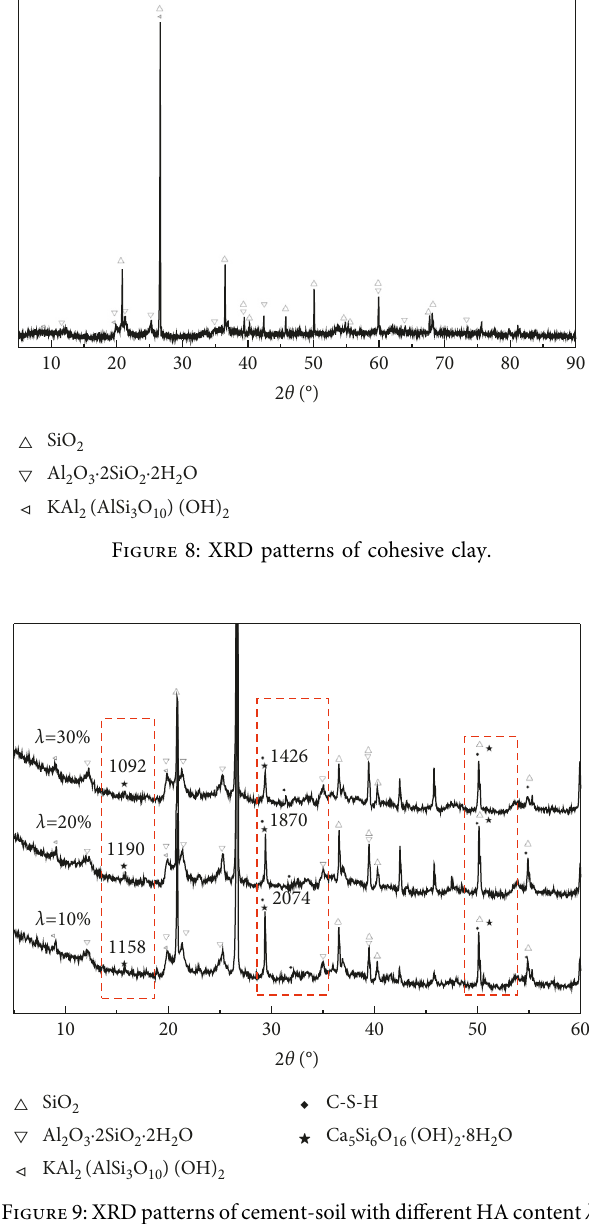
Figure 9: XRD patterns of cement-soil with different HA content λ